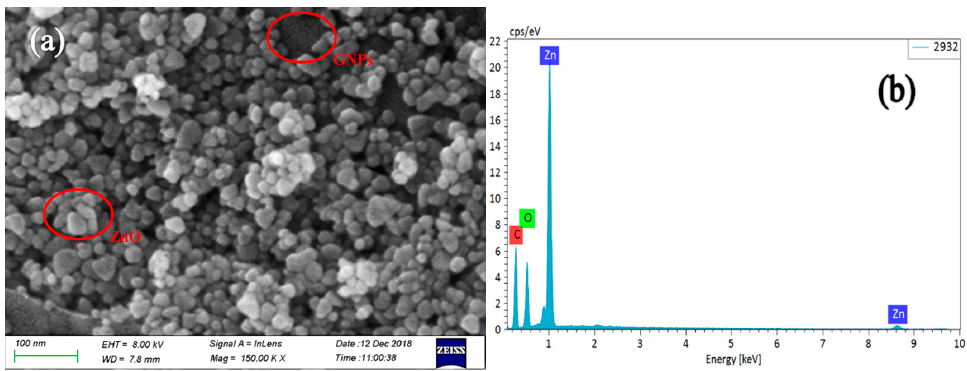
Figure 2. SEM micrograph ( a ) and EDS ( b ) of the GNP-ZnO hybrids powder.